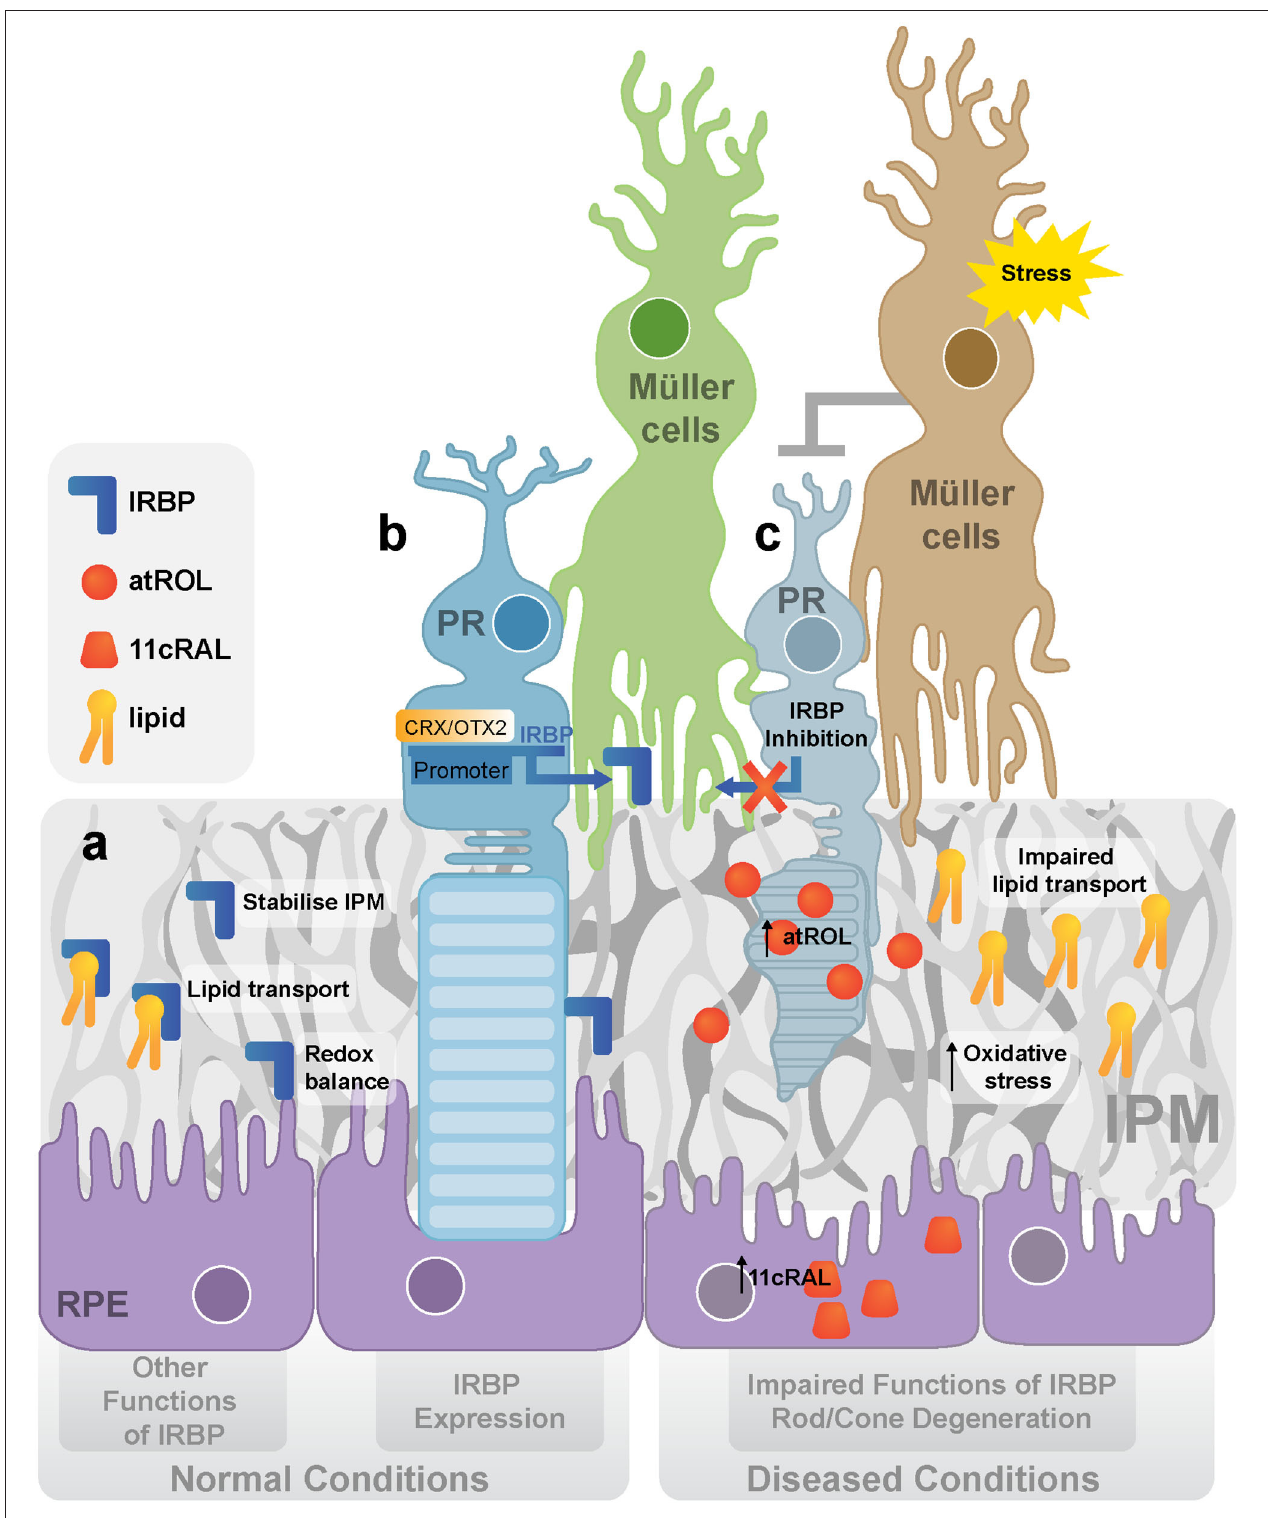
FIGURE 1 | IRBP in normal and diseased retina. (a) The expression and functions of IRBP. IRBP is produced and secreted by photoreceptors. The main function of IRBP is to stabilize IPM, transport lipid between photoreceptors and the RPE and maintain the redox balance in the outer retina. (b) The regulation of IRBP. OTX2/CRX activates the expression of IRBP by binding to its promoter. (c) IRBP dysregulation and rod/cone degeneration under stress. It is proposed that